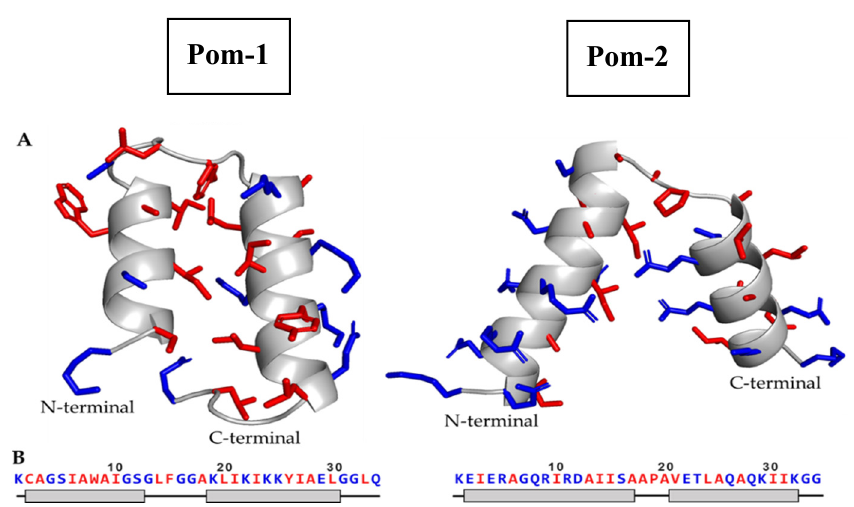
Figure 1. ( A ) Cartoon diagrams of the predicted structure for Pom-1 (left) and Pom-2 (right), modeled using QUARK and SwissModel servers (Manufacturer, City, State abbrev., if USA or Canada, Country), respectively. Residue side chains are represented in sticks. ( B ) Amino acid sequence of Pom-1 and Pom-2 models and its associated secondary structure. The gray boxes represent alpha helix residues; the black lines represent unordered residues. Hydrophobic residues are highlighted in red, hydrophilic residues in blue. Table 1. Structure evaluation of the six predicted models for Pom-1 and Pom-2.